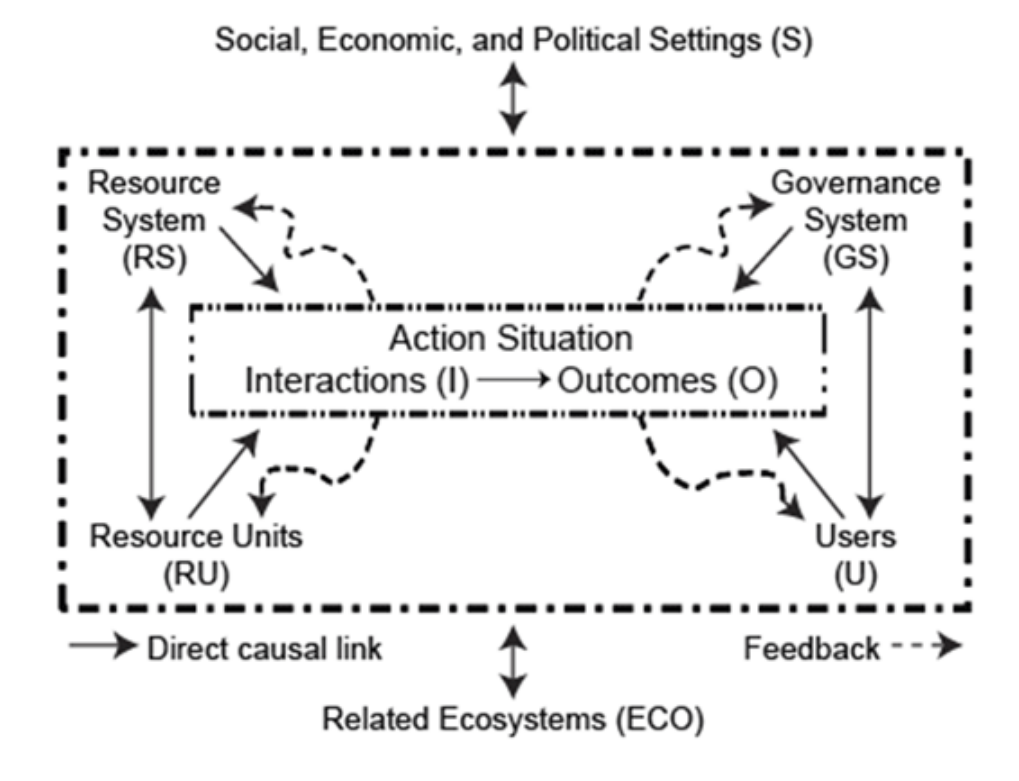
Fig. 1 . The first tier of a framework for analyzing an SES. Source: Adapted from Ostrom